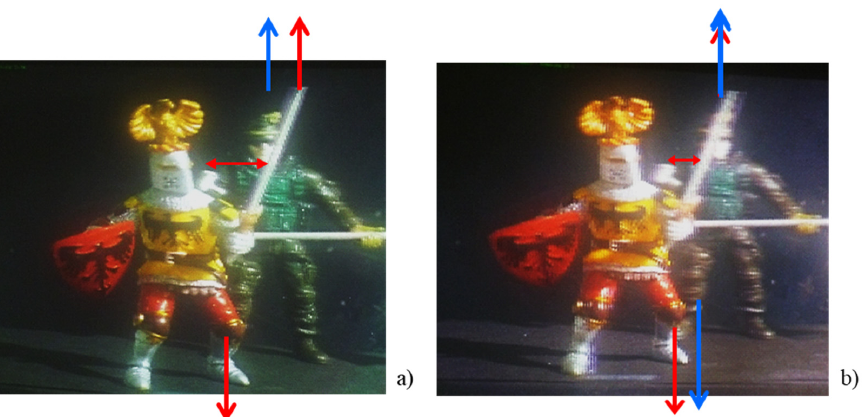
Figure 7. Images at different viewing directions. ( a ) The face of the green warrior is not covered by the sword; ( b ) the face of the warrior is covered by the sword. Displacements of different parts of fighters are shown by arrows.